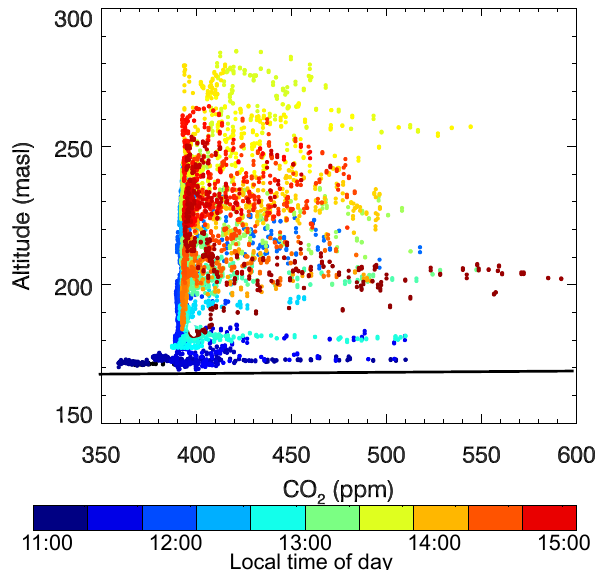
Figure 4. CO 2 ff calculated from flask samples from the Helikite and surface flasks on 26 October 2013.